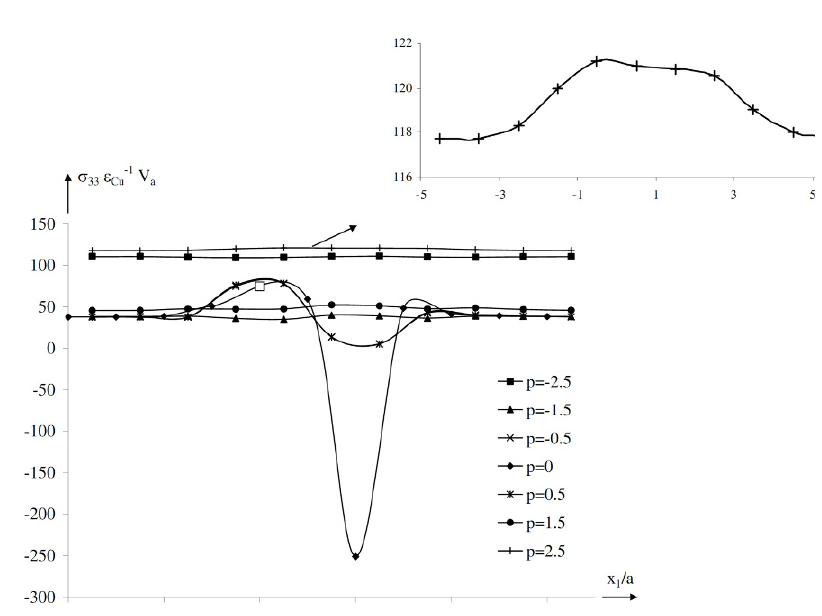
between the vacant site and the Al dopant on their formation energy for three cases of L = 2 a , 4 a , and 6 a is given in Table 5. The formation energy of each configuration is calculated with respect to the total energy